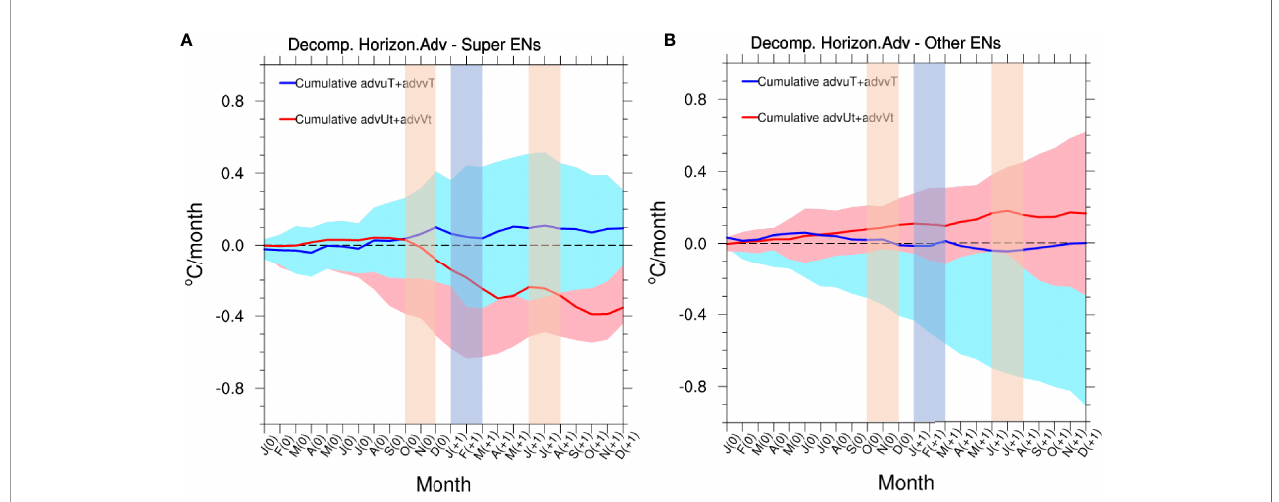
FIGURE 8 | (A) The blue and red lines indicate the cumulative horizontal advection of mean temperature by anomalous currents (advuT + advvT) and horizontal advection of anomalous temperature by mean currents (advUt + advVt) for super El Niño composite, respectively. (B) Same as in (A) but for other El Niño composite. Shading indicates ±1 standard deviations of every